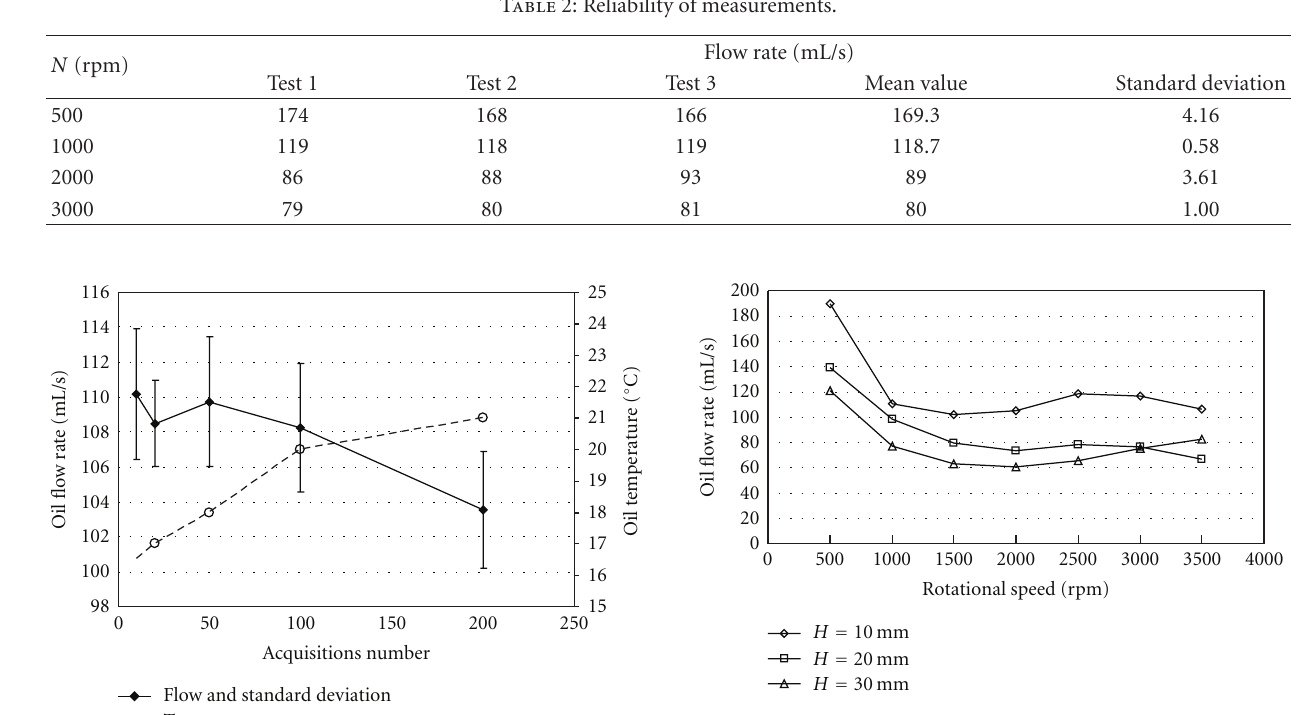
Figure 5: Typical evolutions of oil flow